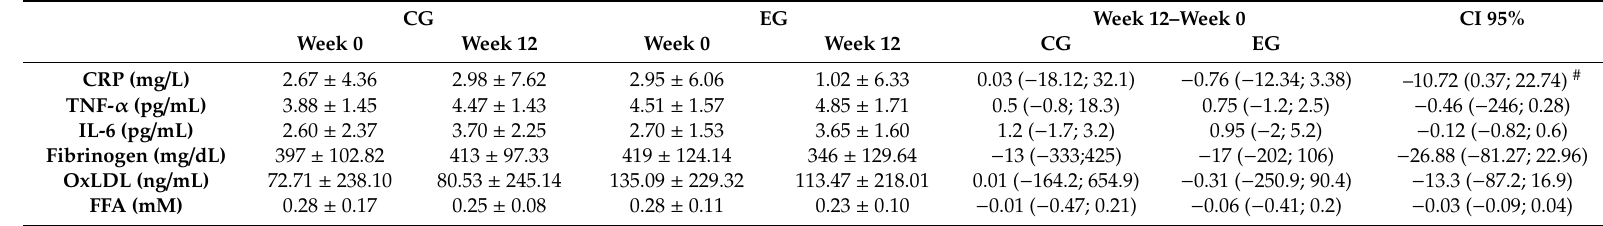
Table 4. Inflammatory biomarker concentration before and after the intervention.